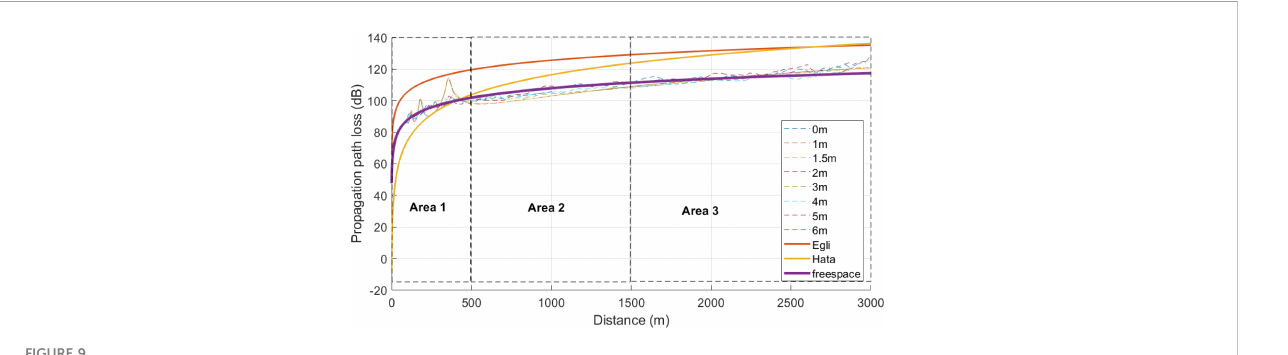
FIGURE 9 Simulated propagation path loss under various wind